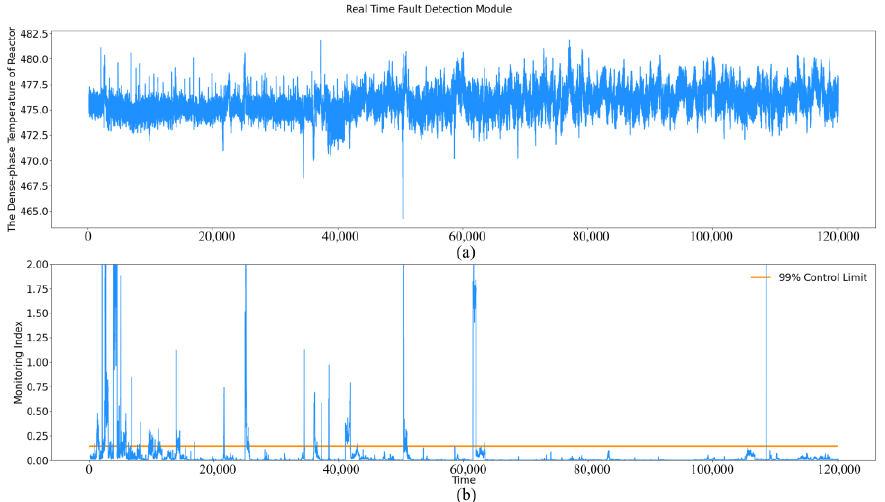
Figure 8. Three-month online process monitoring results (the model is trained with data labeled by the Euclidean distance-based method): ( a ) Original data of the key variable; ( b ) Fault detection re- sults.